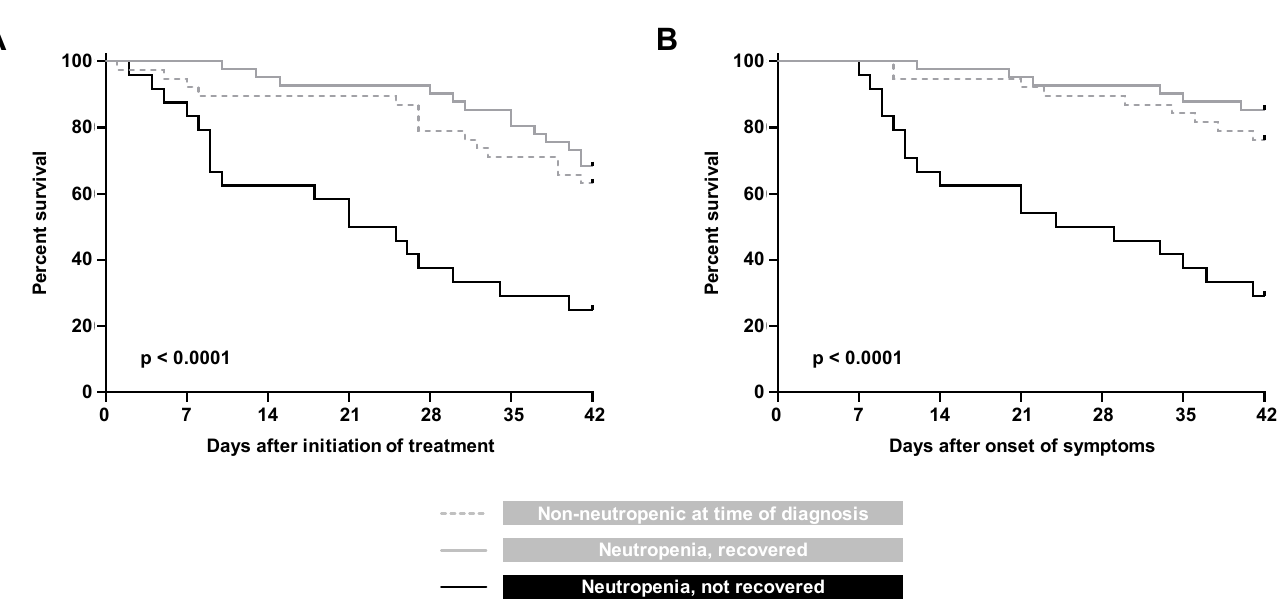
Figure 1. Kaplan–Meier curves of progression to 42-day mortality in patients with hematologic malignancy and recipients of hematopoietic stem cell transplants with breakthrough mucormycosis on Mucorales-active versus other mold-active antifungals as measured from ( A ) initiation of treatment and ( B ) onset of symptoms.